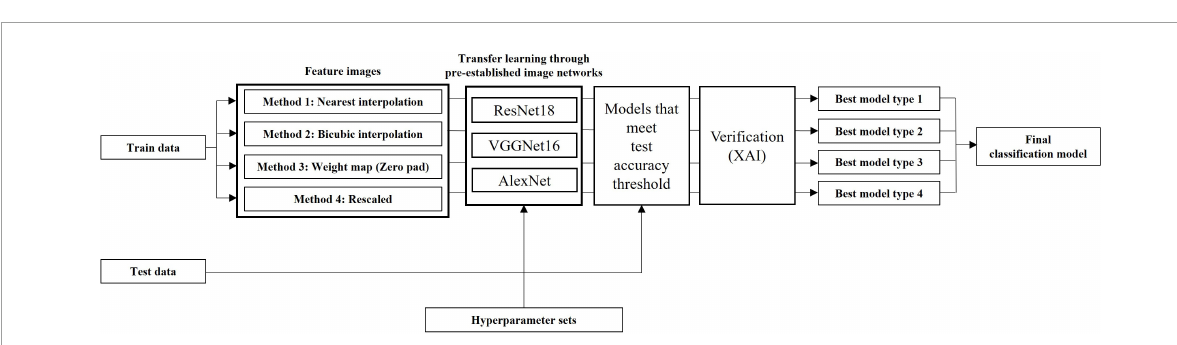
FIGURE7 Modeling pipeline which summarizes model yielding and verification